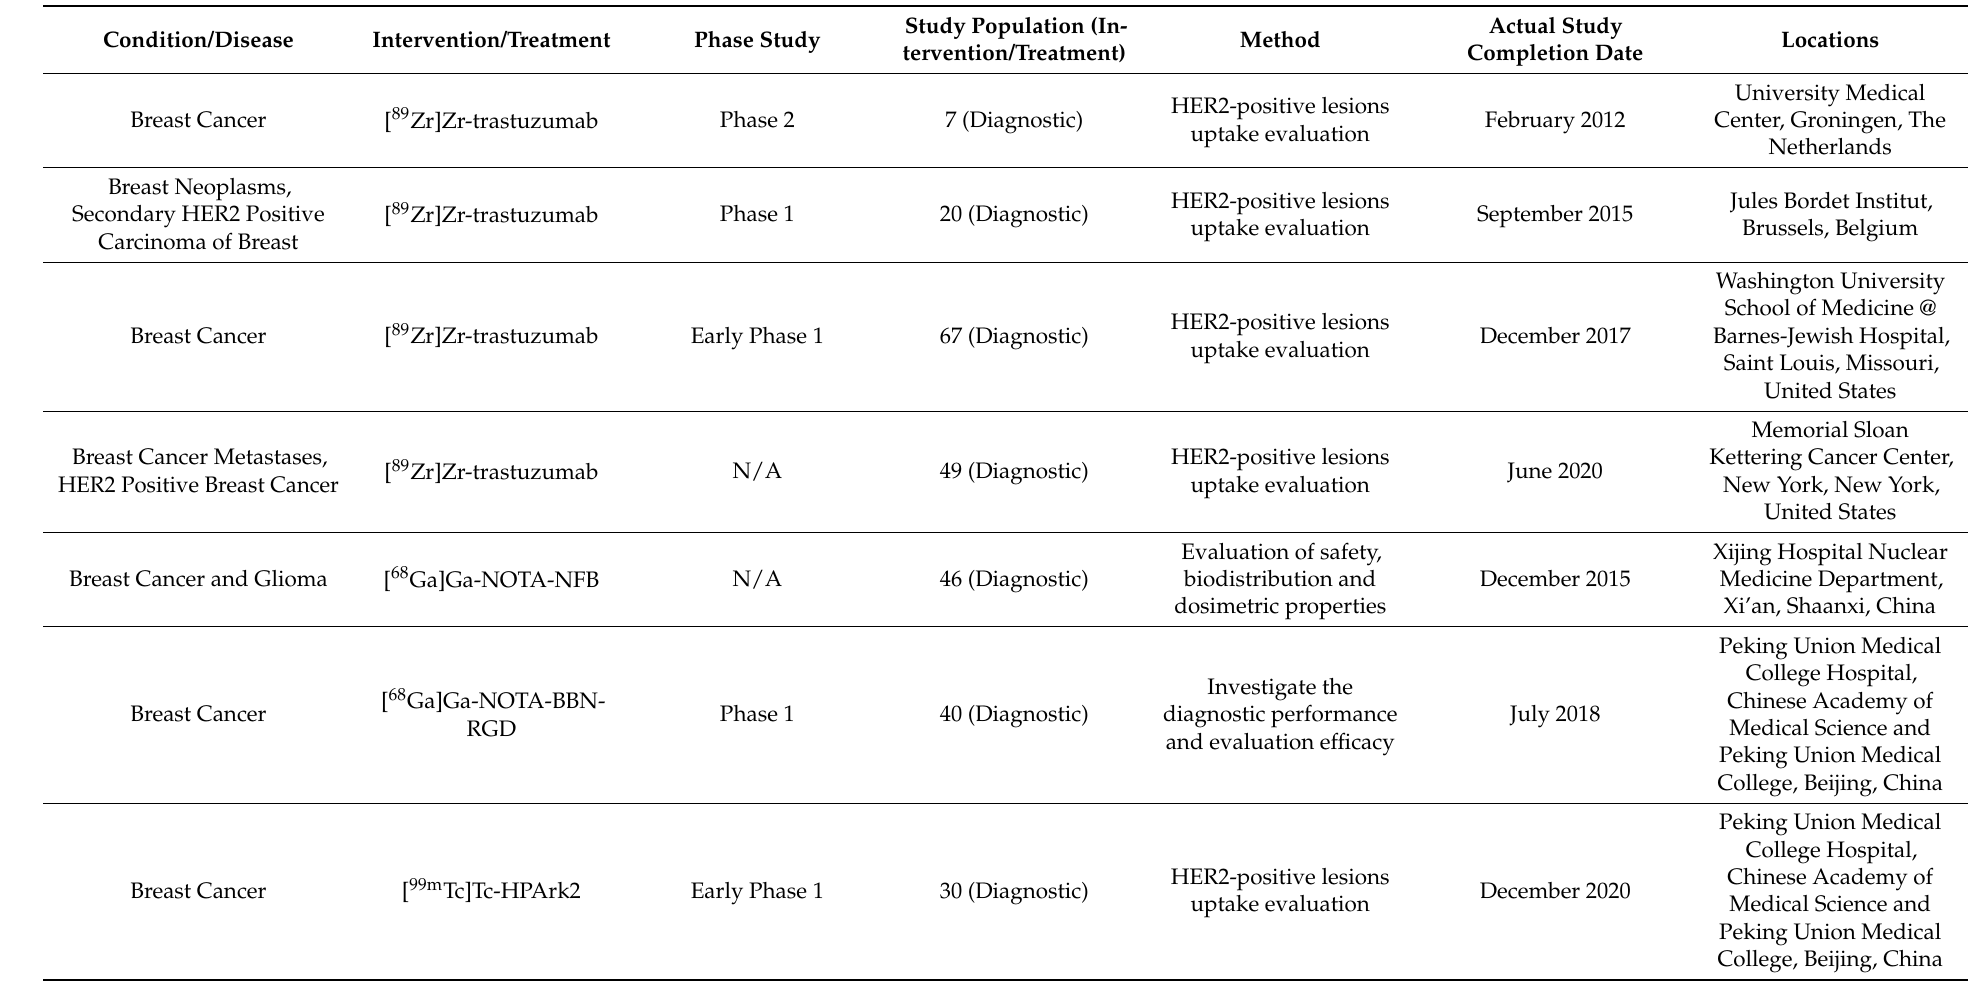
Table 1. An overview of completed clinical trials performed on breast cancer conducted by: clinicaltrials.gov (accessed on 20 April